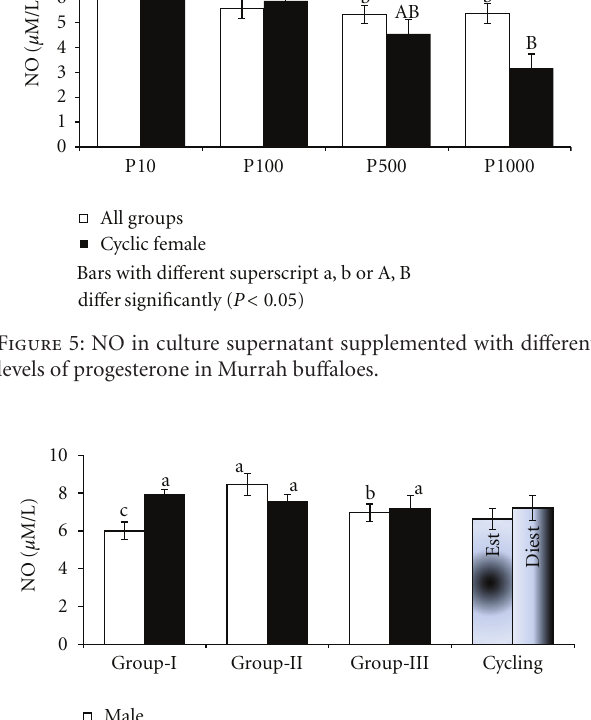
Figure 4: NO in culture supernatant supplemented with proges- terone in Murrah bu ff aloes.